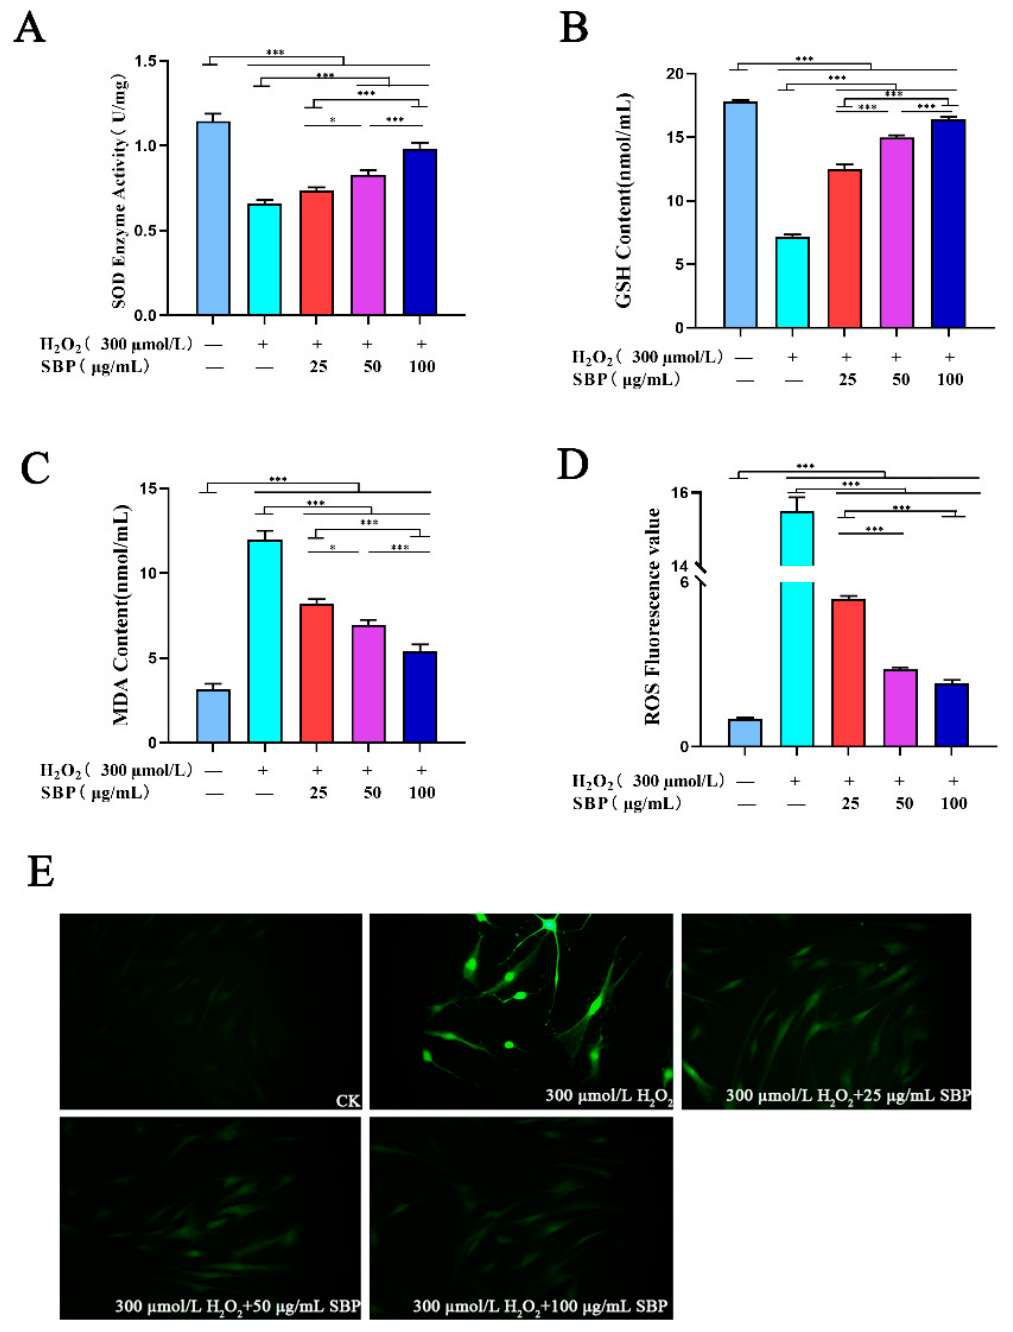
Figure 3. Effects of SBP on the SOD activity, GSH, MDA, and ROS content in H 2 O 2 -induced aging HSFs using related kits. ( A – D ): activity of SOD and contents of GSH, MDA, and ROS in cells treated with different experiments, respectively. ( E ) Fluorescence images of ROS in cells under different experimental conditions. In the figure “+” means added, “ − ” means not added. Results are the mean ± SD of three independent experiments. * p < 0.05, *** p < 0.001 indicating significant differences compared with the various experimental groups.